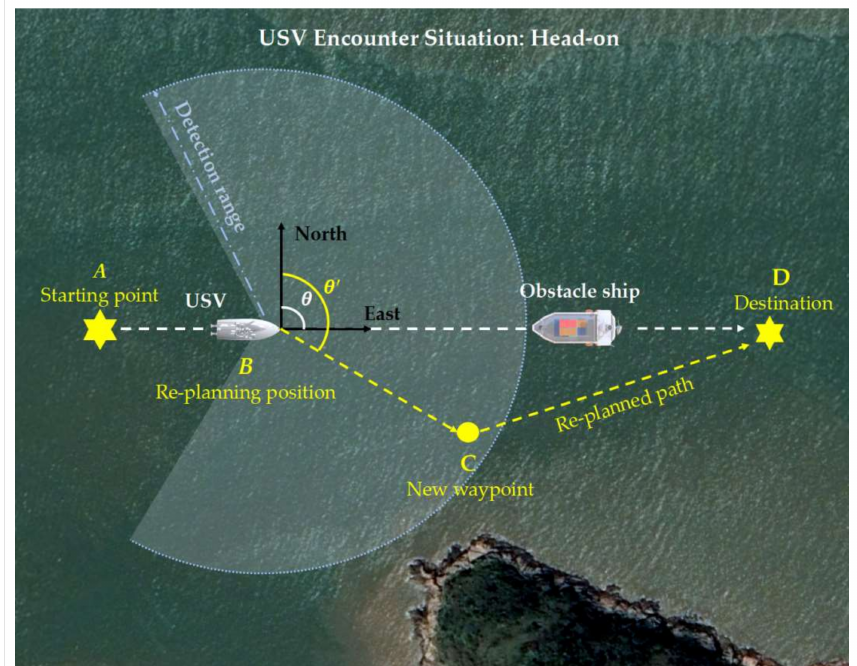
Figure 5. Illustration of a USV collision avoidance path replanning under a head-on